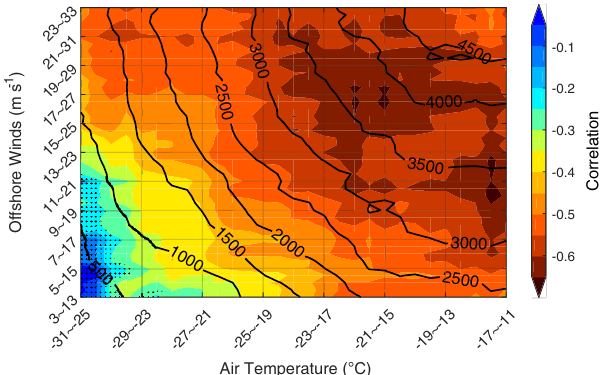
Fig. 7 The correlation coef fi cient between the TCI thickness and the TNBP area in different situations. The fi lled contour map shows the correlation between the TCI volume and the TNBP area in different ranges of offshore wind speed and air temperature; the contour map with labels shows the mean area in this range. The range span of air temperature is 6 °C; that of offshore wind is 10 m s − 1 . Dots on the map mark the insigni fi cant results ( p > 0.01). The partial correlation/correlation coef fi cient in winter is shown in Supplementary Fig. Its resolution is 12.5 km × 12.5 km. SMOS ice thickness is